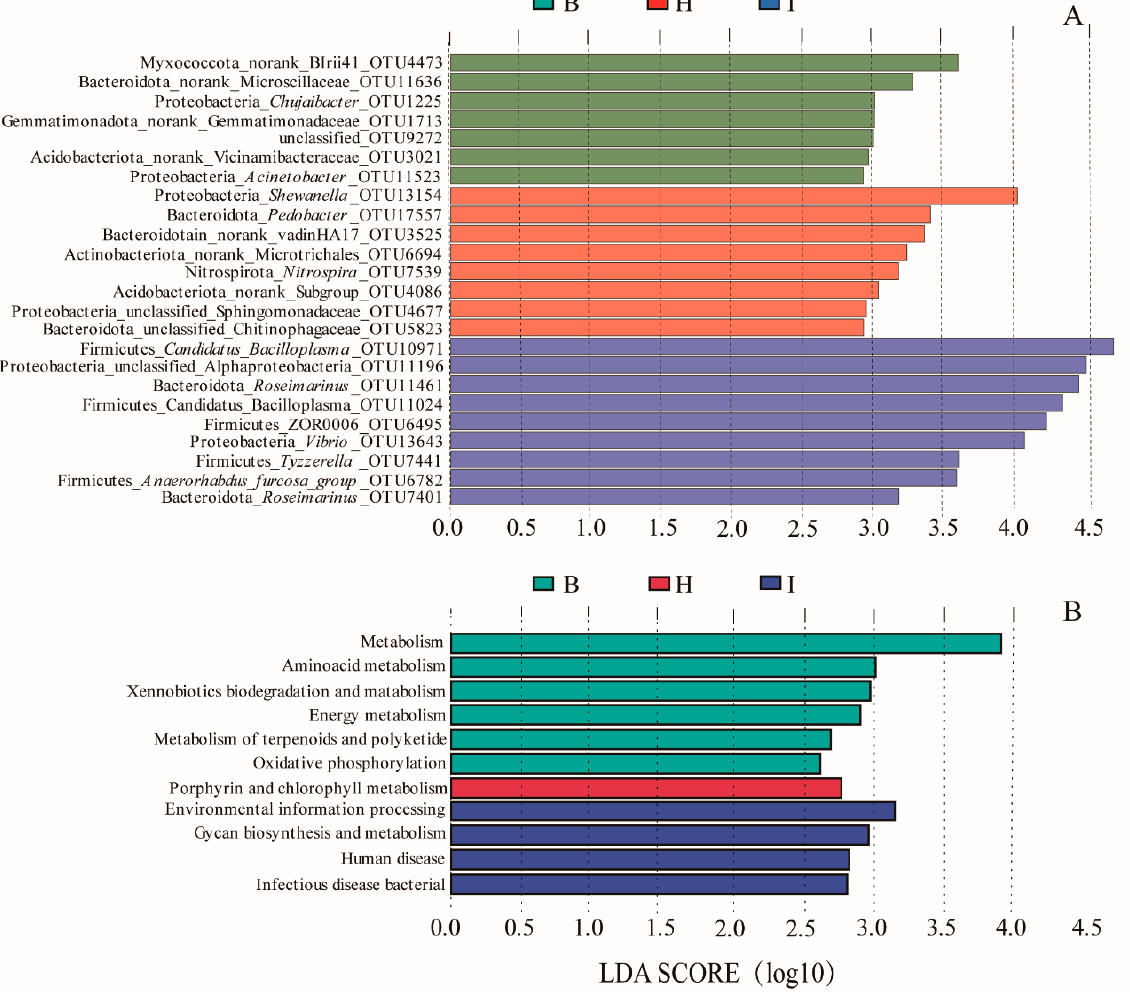
Figure 5. ( A ) LEfSe showing differences in the bacterial communities at the OTU level for three sites. ( B ) LEfSe showing differences in the predicted functions of different sites as predicted by Tax4Fun analysis. B: hemolymph (B1–B12); H: hepatopancreas (H1–H12); I: intestine (I1–I12).